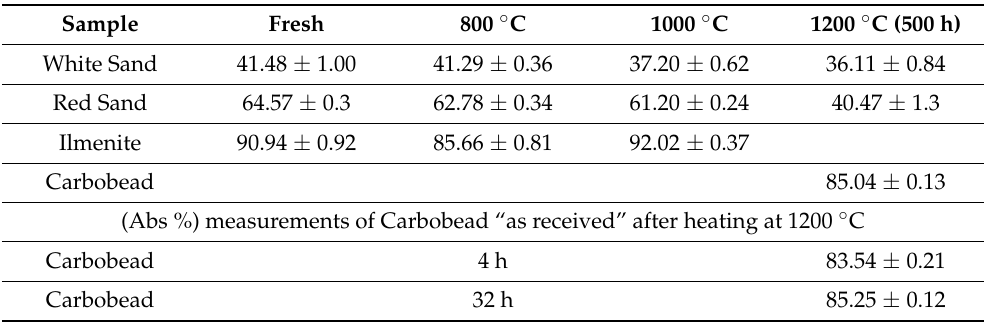
Figure 3. Spectral absorptance of the white sand samples (“as received” and after the aging test) over the wavelength. Table 3. Solar absorptivity (Abs %) measurements for different particulate materials “as received” and after the aging test.